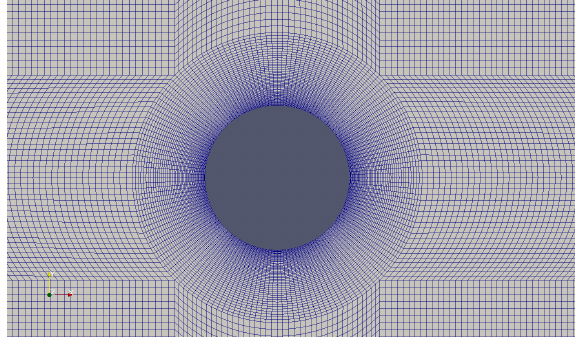
Figure 4. Near body mesh used for the